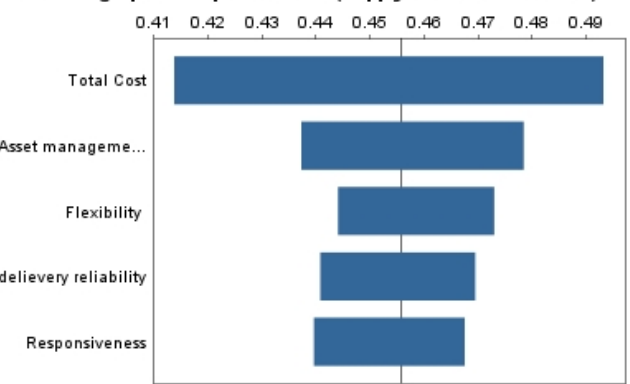
Figure 4. Tornado graph of factors for expected value of supply chain